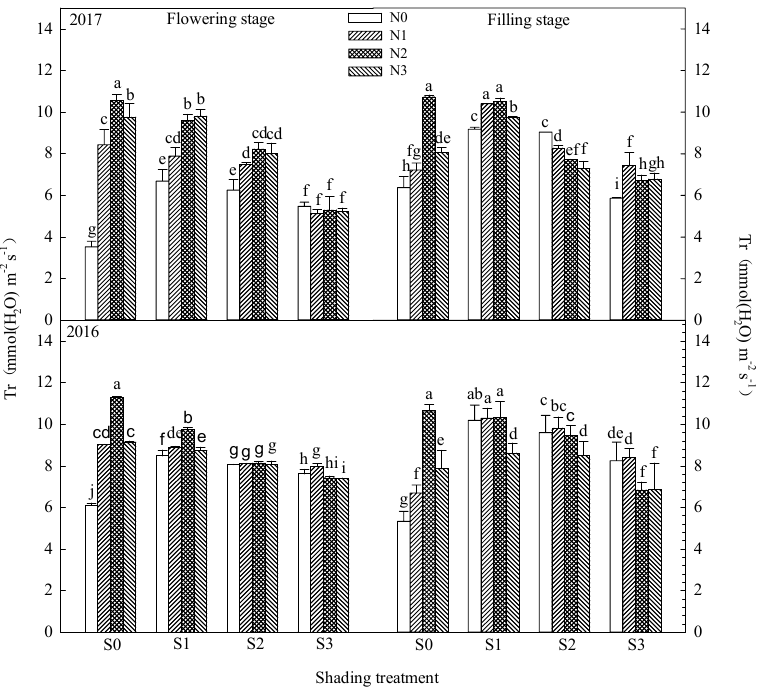
Figure 3. Effect of light and nitrogen treatment on the transpiration rate (Tr) of wheat. Bars indicate SD (n = 3). Values within columns followed by the same letter are statistically insignificant at the 0.05 level.